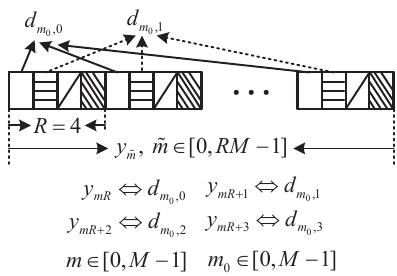
Figure 3. Separation of received signals of different d m